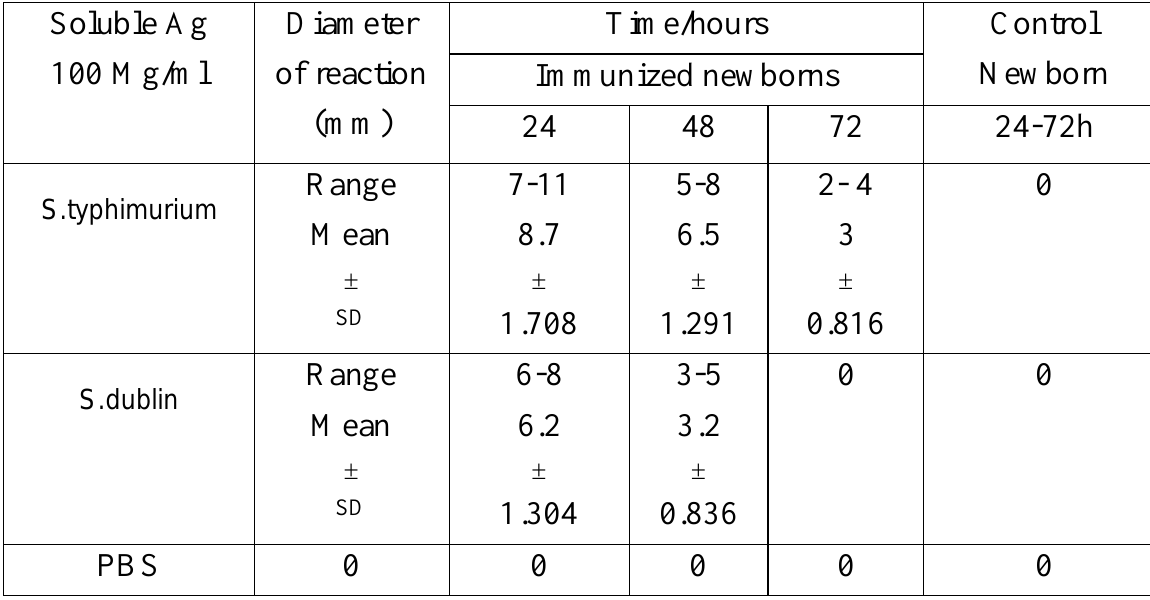
Table (2) DTH- skin reaction of the newborns of vaccinated dams with aro S.typhimurium SL